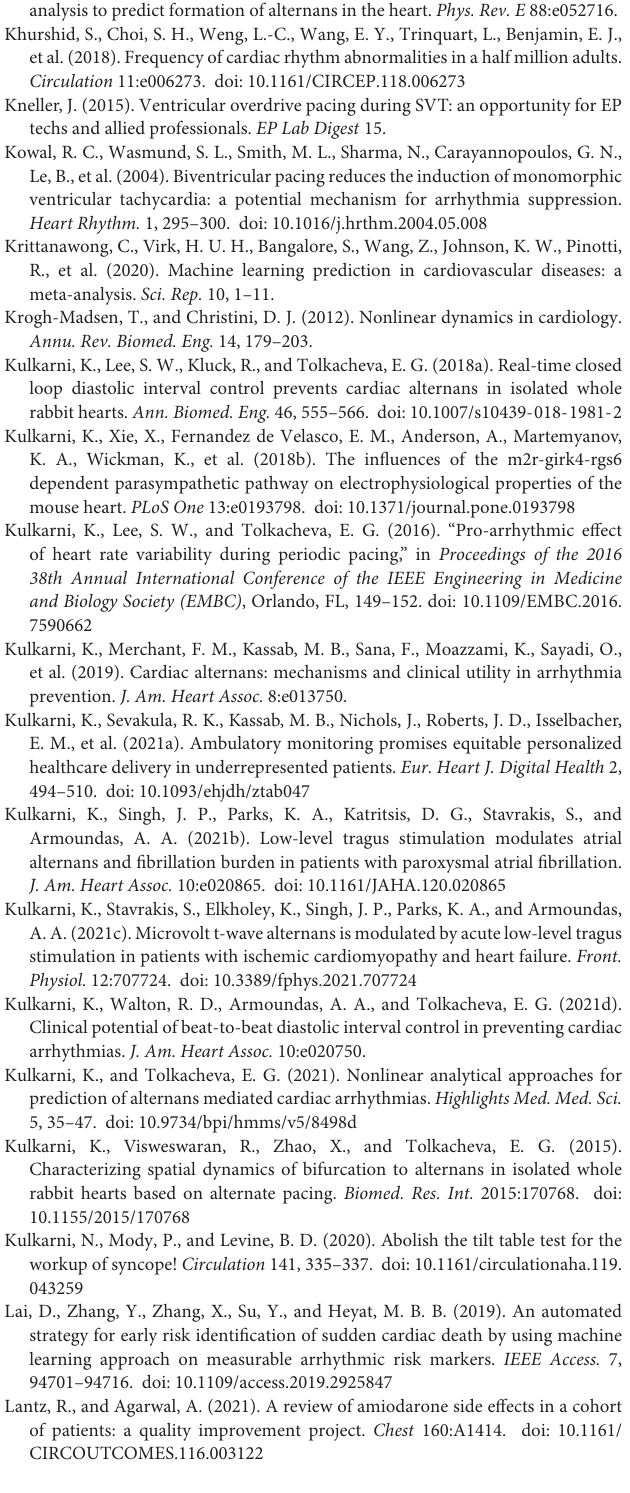
Frontiers in Physiology |